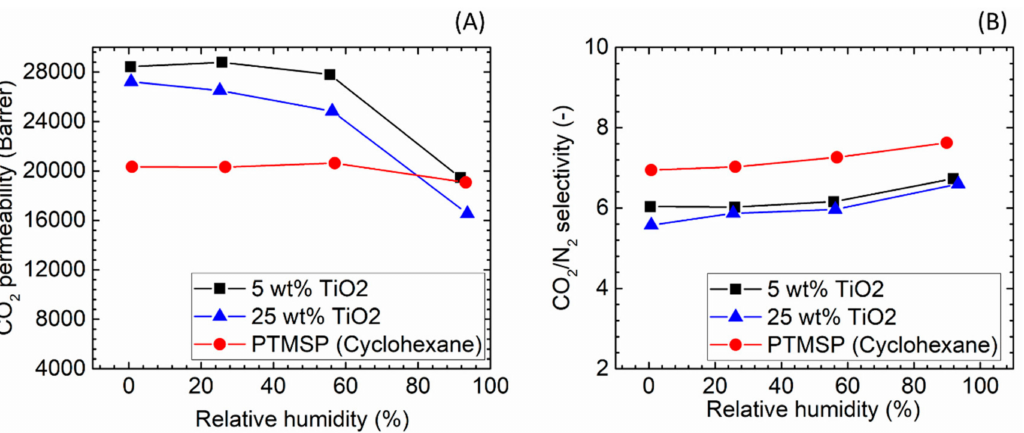
Figure 14. Gas separation performance of PTMSP/TiO 2 hybrid membranes (Cyclohexane used as solvent). ( A ) CO 2 permeability and ( B ) CO 2 /N 2 selectivity.